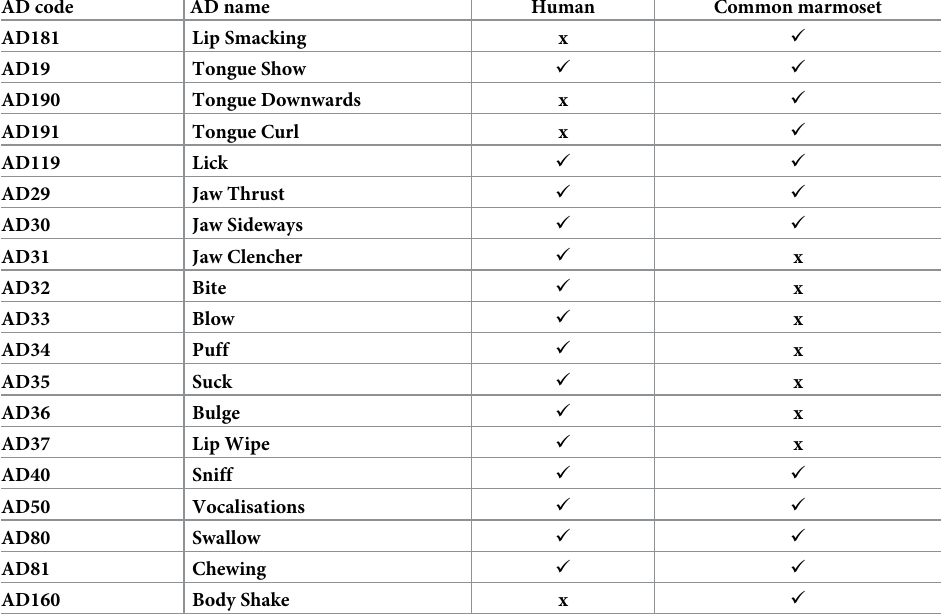
Table 3. Comparison between other FACS Action Descriptors (AD) for humans [3] and common marmosets. ✓ - present,